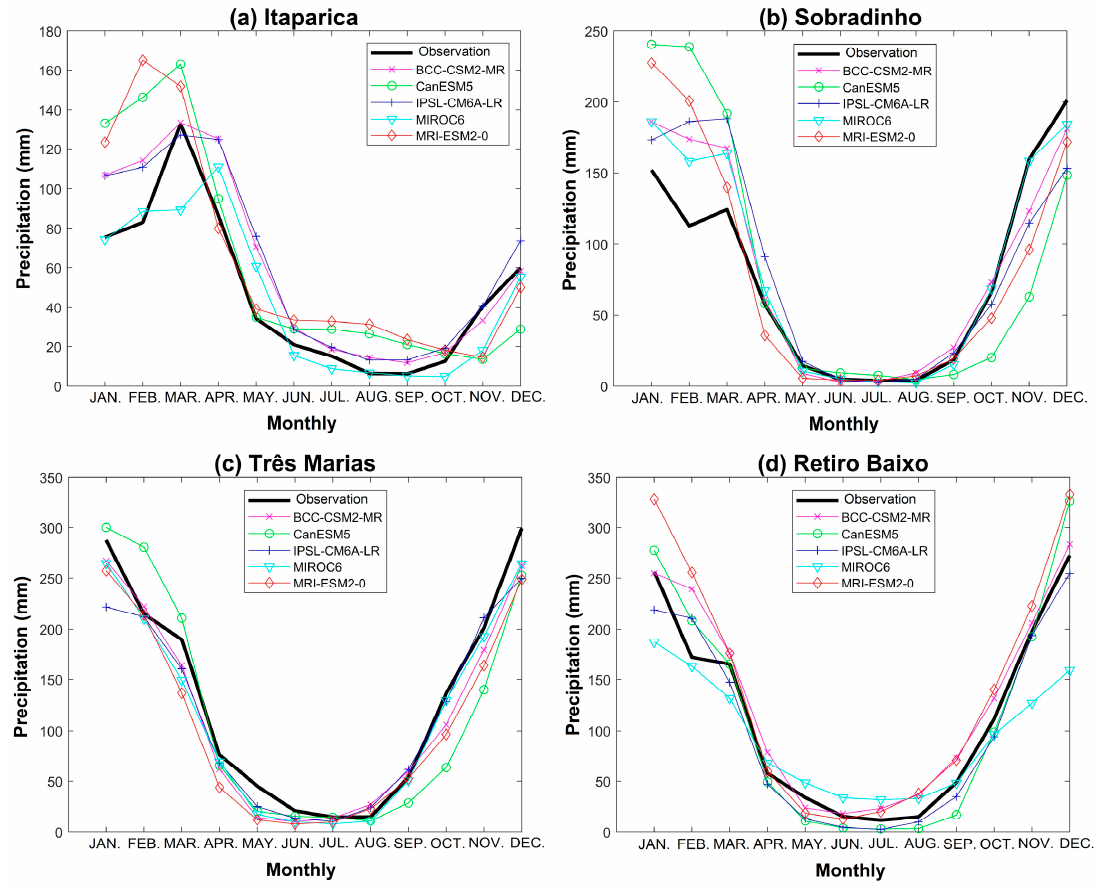
Figure 5. Seasonality of the CMIP6 models BCC-CSM2-MR, CanESM5, IPSL-CM6A-LR, MIROC6 and MRI-ESM2-0 compared to the observed precipitation.